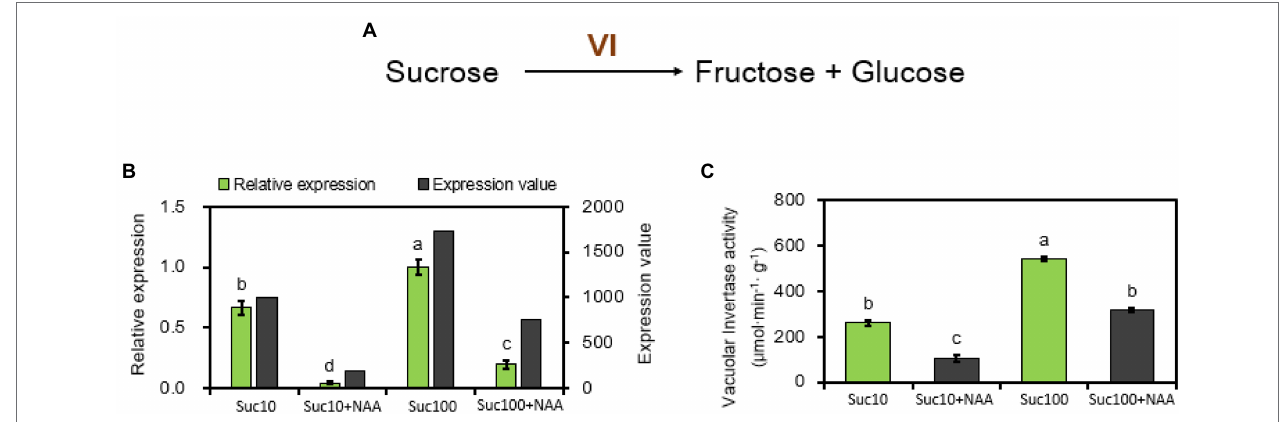
FIGURE 2 | Vacuolar invertase ( RhVI1 ) is regulated by auxin (NAA) and sucrose (Suc) in stem explant buds. (A) Catalysis pathway mediated by RhVI1; (B) Expression level of RhVI1 (dark and light green columns correspond to RNA-seq and RT-qPCR results respectively) , RNA-seq, and RT-qPCR results with sucrose alone (Suc10, Suc 100) and with auxin and sucrose (Suc10 + NAA and Suc100 + NAA); and (C) total activity of RhVI1 in buds supplied with sucrose only (Suc10 and Suc100) or NAA combined with sucrose (Suc10 + NAA and Suc100 + NAA). Data are the means ± SEs of three biological replicates. Suc10, 10 mM